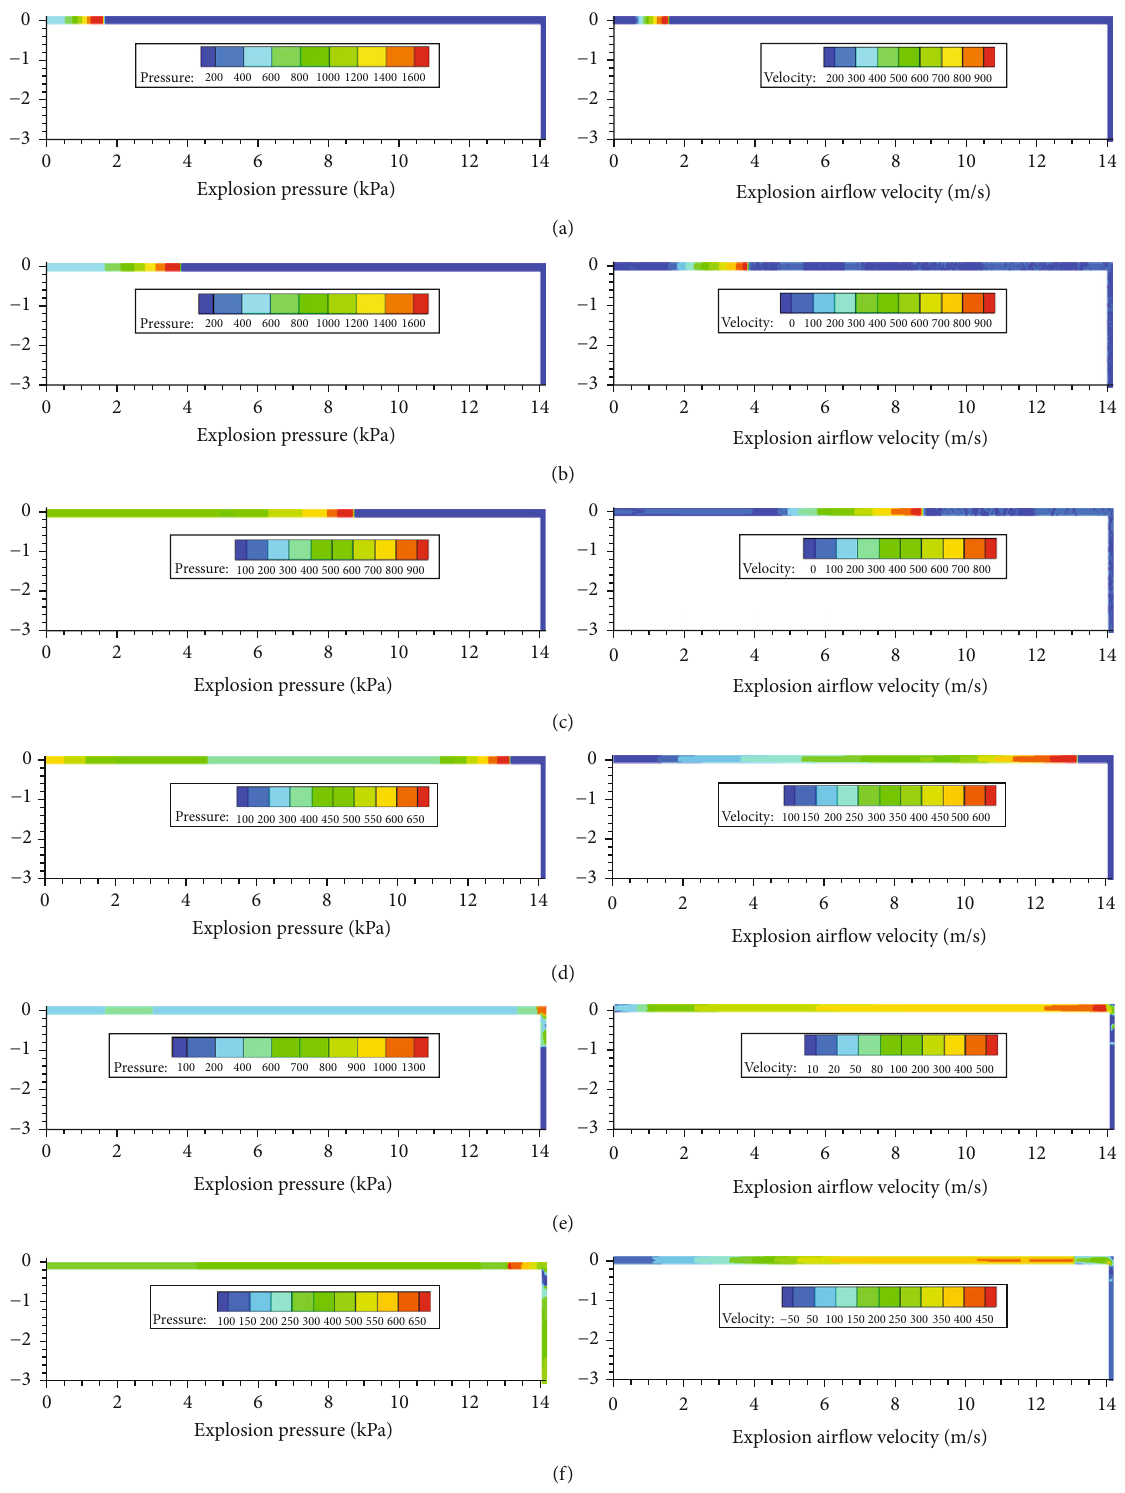
Figure 8: Simulation diagrams of explosion pressure and air fl ow velocity at di ff erent times of the bend pipe ( V = 0 : 23 m 3 , α = 90 ° ): (a) t = 0 : 8ms , (b) t = 2 : 0 ms , (c) t = 5 : 4 ms , (d) t = 9 : 8ms , (e) t = 12 ms , and (f) t = 15 : 1 ms